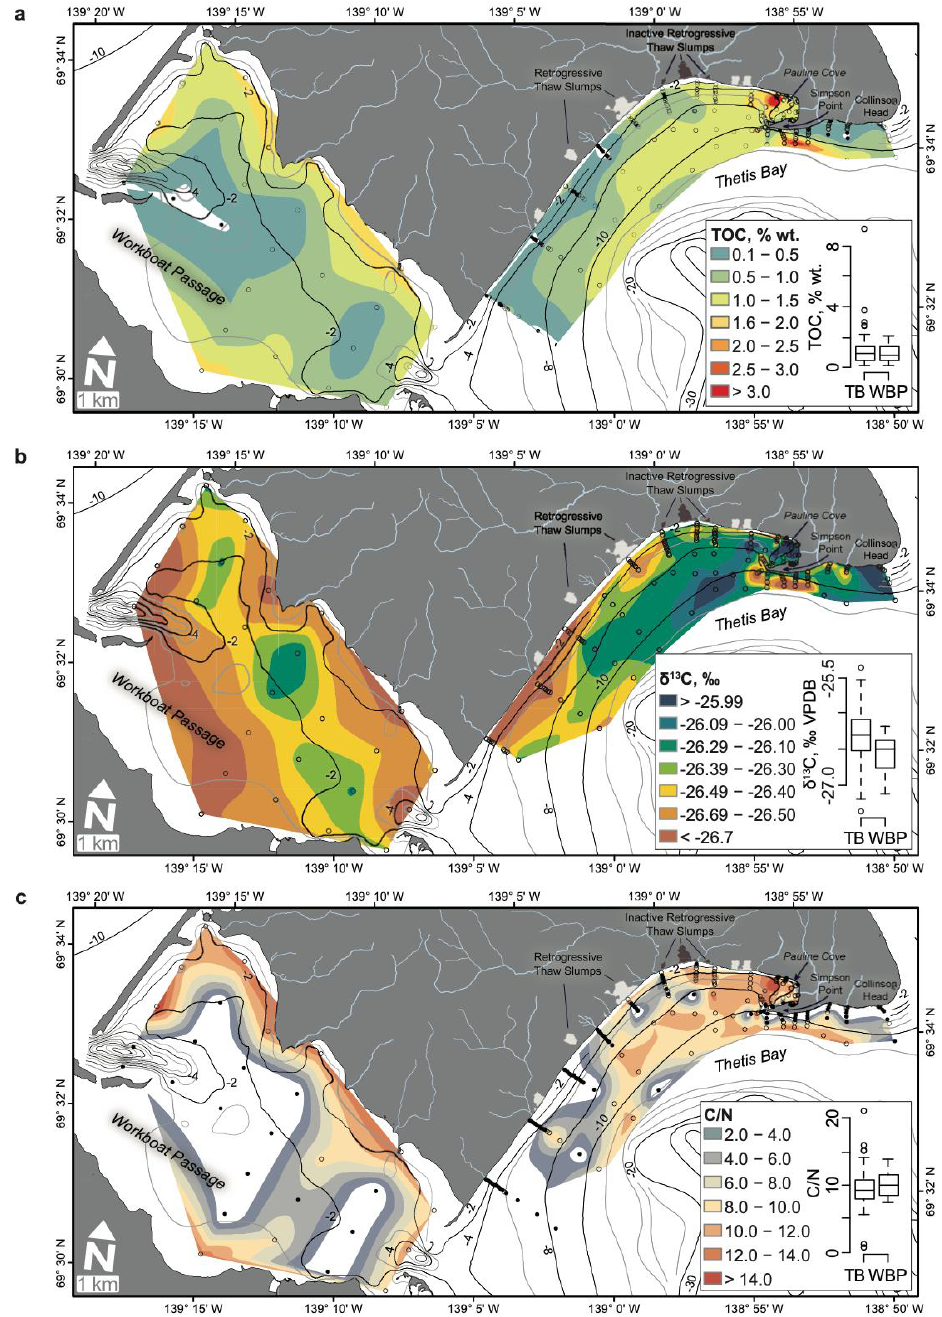
Figure 3. The spatial distribution and box plots of ( a ) total organic carbon content, ( b ) stable carbon isotopes (δ 13 C) and ( c ) carbon-nitrogen (C/N) ratio. Note higher δ 13 C values in Pauline Cove and lower values along the fringes of WBP. Additionally, note high C/N in Pauline Cove and along the fringes of WBP. Locations of samples with either N or TOC below the detection limit are indicated by black solid circles and were not used in the interpolation. Isobaths show 1 m contours in WBP, and 2 m contours in TB